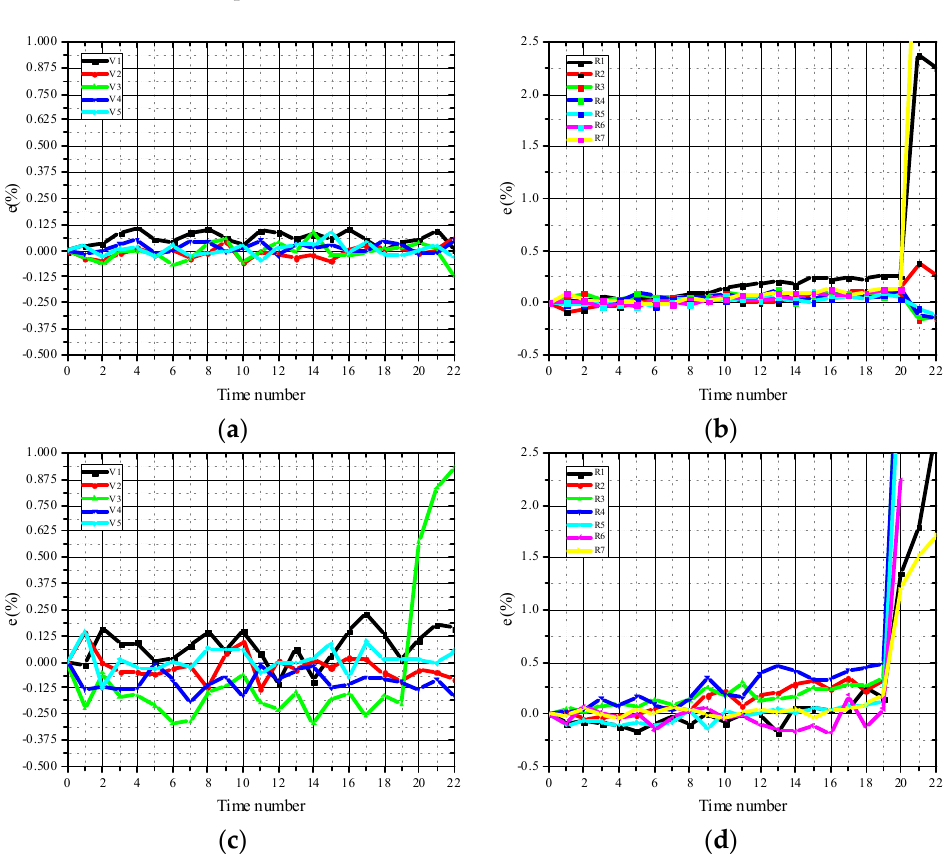
Figure 7. Strain − time curves of characteristic points: ( a ) vertical loading direction of mortar speci- mens; ( b ) loading direction of mortar specimens; ( c ) vertical loading direction of concrete specimens; ( d ) loading direction of concrete